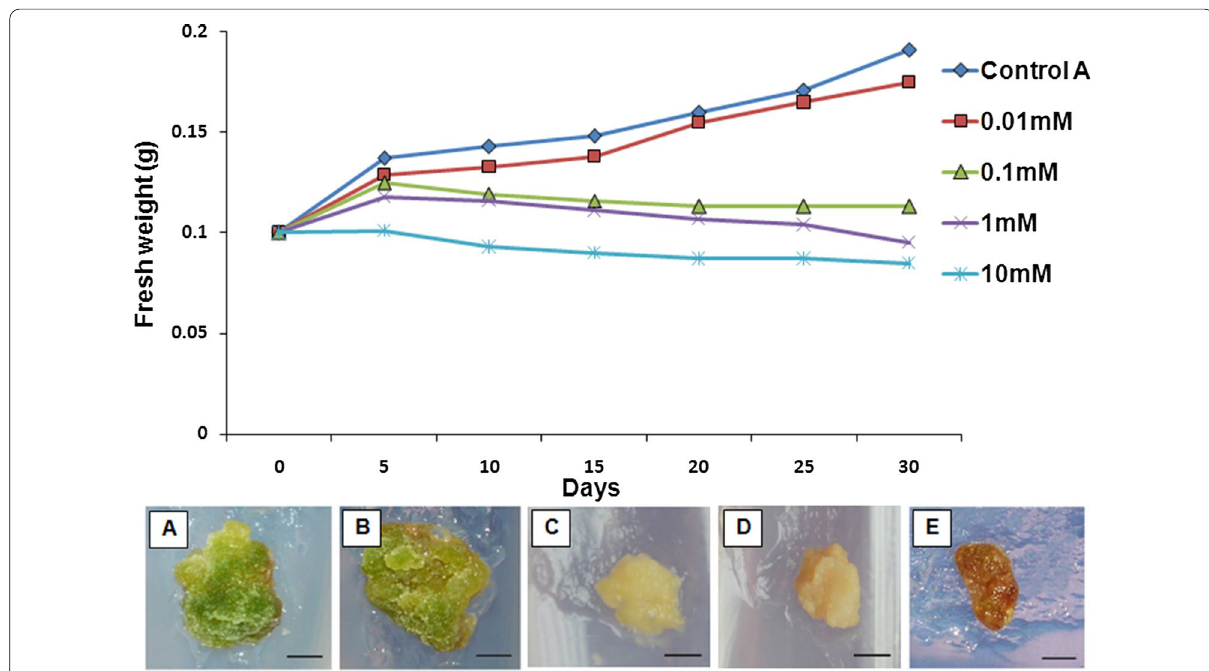
Fig. 4 Effect of different concentrations of 5-fluorouracil on changes in fresh weight of callus of Lathyrus sativus. ( A ) Control ( B – E ) callus growth with increasing concentration of 5FU. Scale bar 5 =